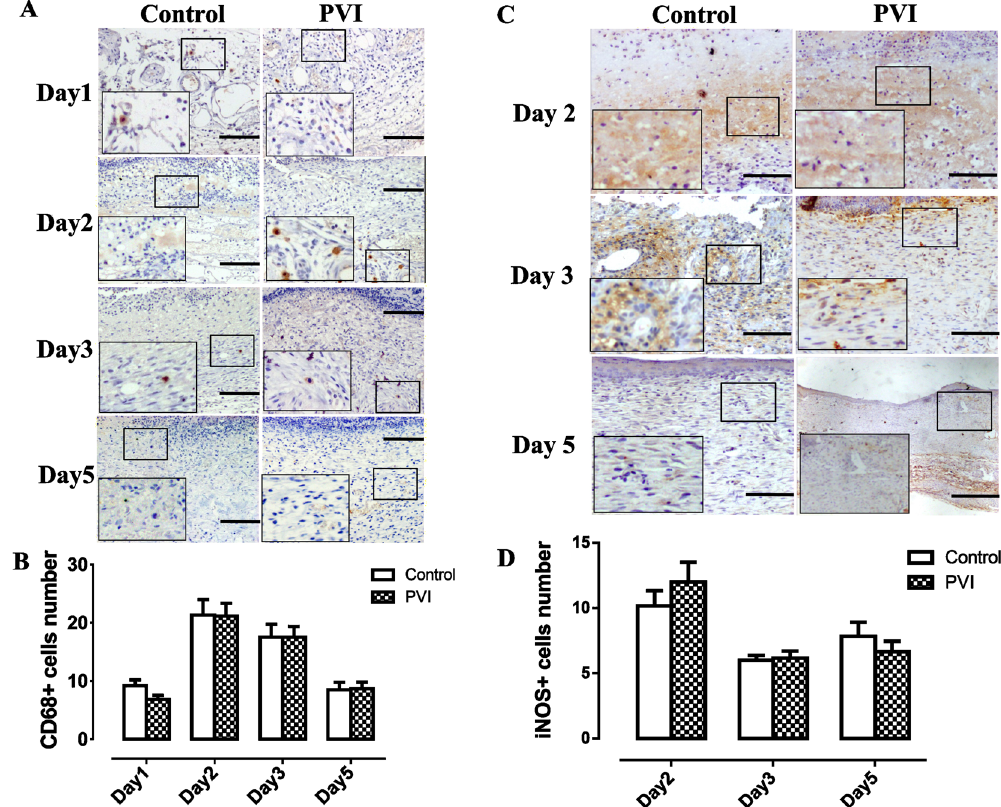
Figure 5. The effect of povidone-iodine (PVI) treatment on macrophages. ( A ) Representative immunohistochemical CD68 stained wound sections. Scale bar = 50 μ m. ( B ) Quantitative analysis of CD68 + cells (/high power fields). ( C ) Representative immunohistochemical inducible nitric oxide synthase (iNOS) stained wound sections. Scale bar = 50 μ m. ( D ) Quantitative analysis of iNOS + cells (/high power fields). Data are means ± S.D, n =